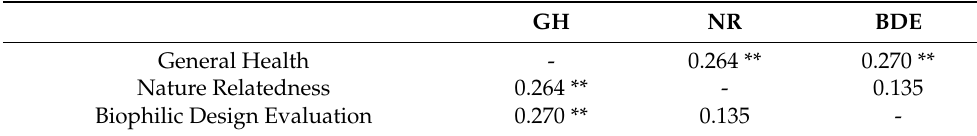
Table 10. Intercorrelations between responses of three